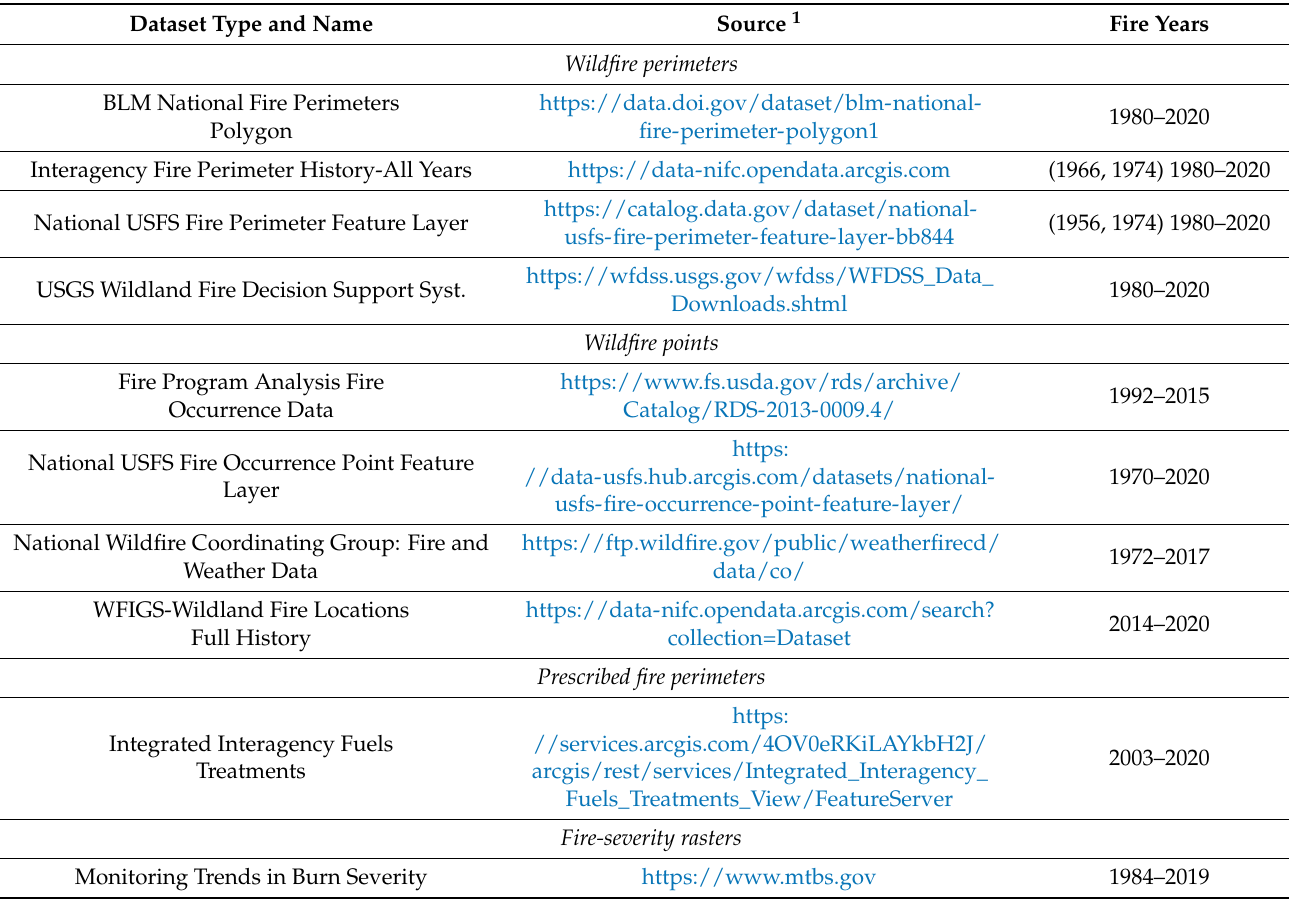
Table 2. Sources of modern digital fire-history evidence in the San Juan